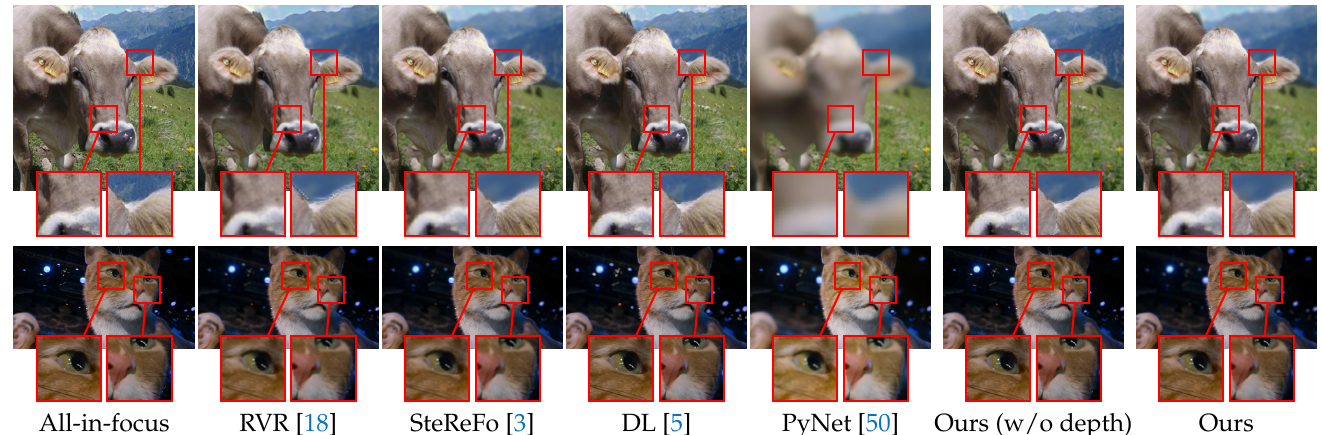
Figure 12. Qualitative results on the NJU2K dataset. Best viewed zoomed in on-screen.